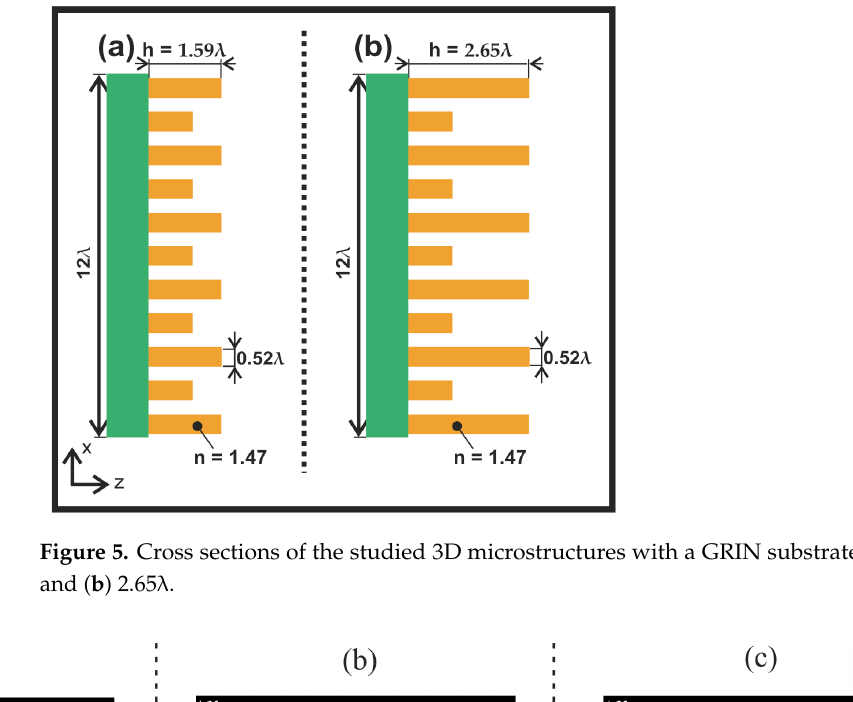
Figure 4. Cross sections of the studied 3D microstructures with a GRIN substrate in the xz plane.